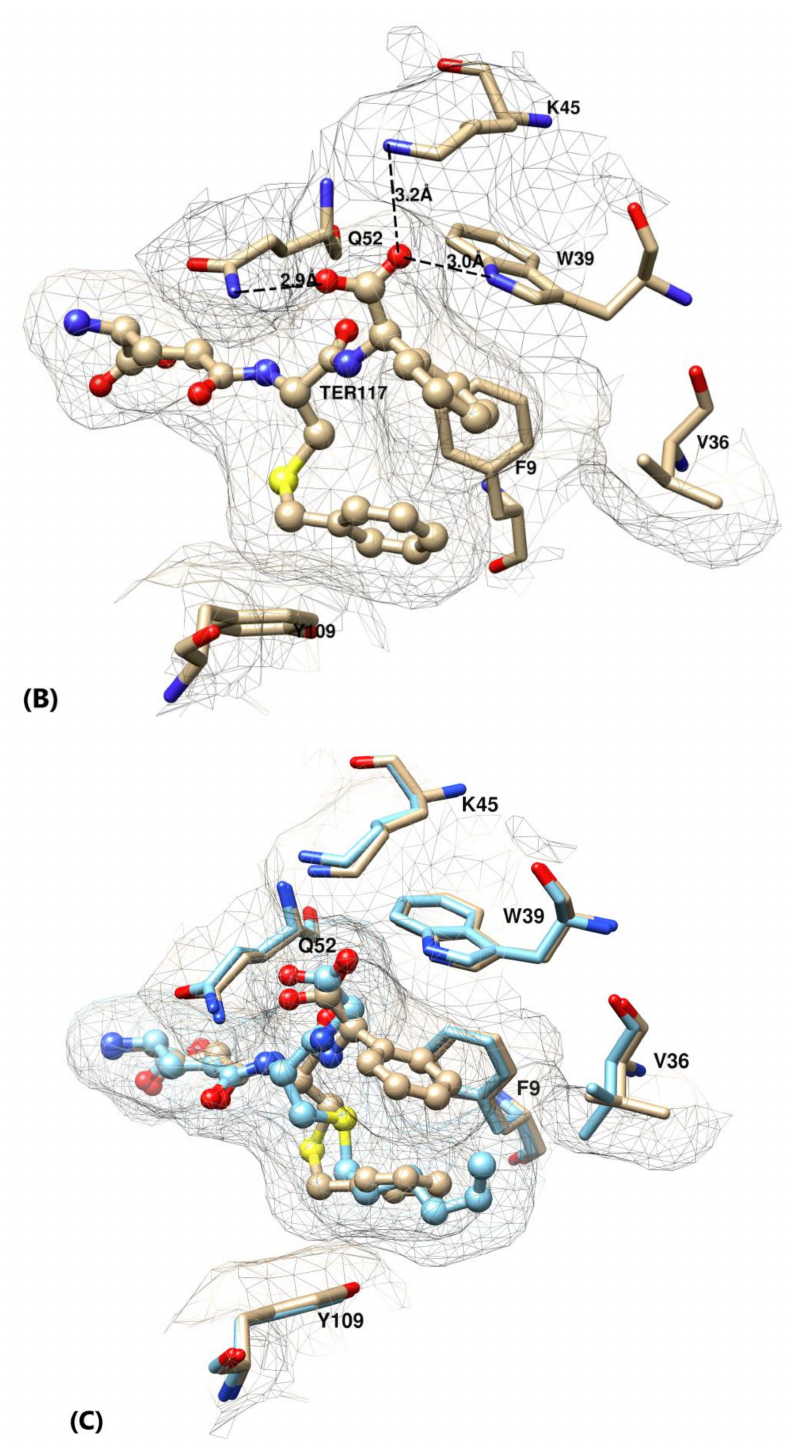
Figure 2. ( A – C ) Active site of glutathione transferase (GST) P1–1 in complex with TER117 based on crystal structure 10GS. ( A ) Interactions of the C-terminal R(-)-phenylglycine of TER117 with the three mutated residues Trp39, Lys 45, and Gln52. ( B ) The hydrophobic pocket formed by residues Phe9, Val36, and Tyr109 by accommodating the phenyl group of TER117. Note the intramolecular interaction of the S-benzyl substituent of TER117 with the phenyl group. ( C ) Superposition of the structure of GST P1–1 with S-hexylglutathione (light blue, pdb 9GSS) on the TER117 complex showing the similar poses of the S-benzyl and S-hexyl